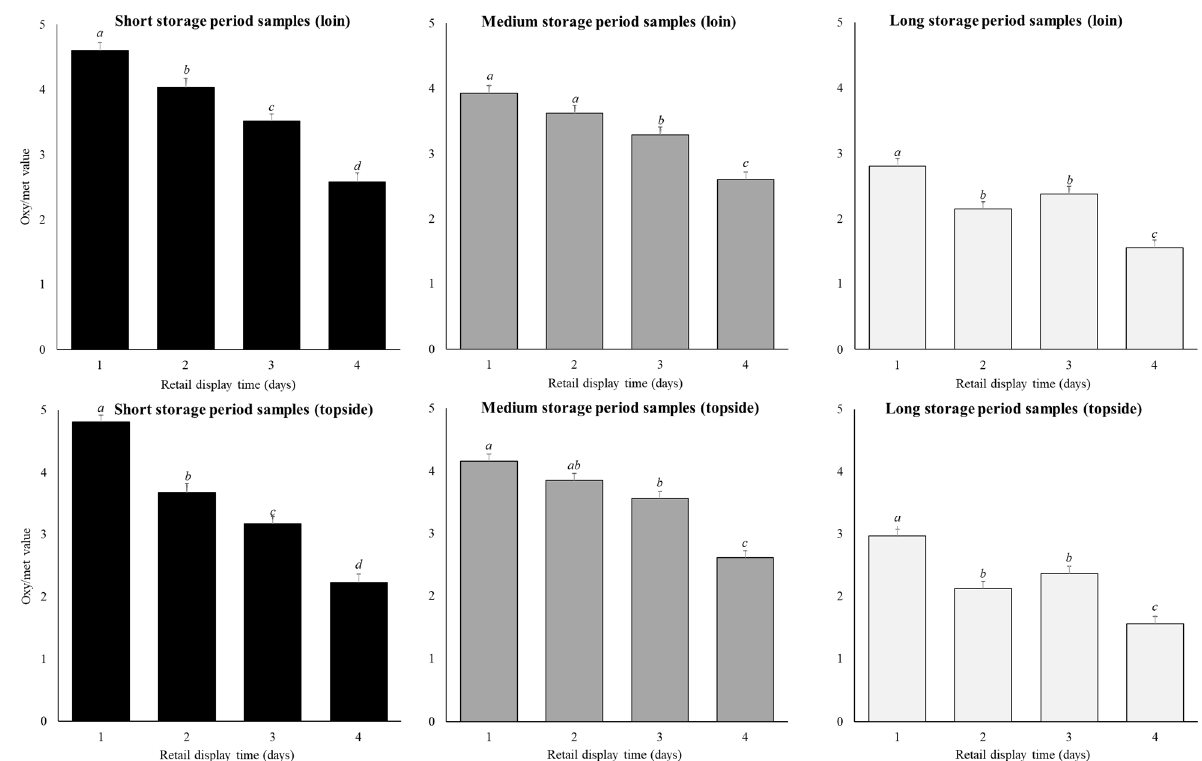
Figure 4. Predicted means ( ± SE) for the storage period (short, medium, long), and retail display time (1, 2, 3, 4 days) for loin and topside samples on oxy/met values. Within a cut and storage period the annotations ( a – d ) that differ indicate significant difference ( p < 0.05) across retail display.